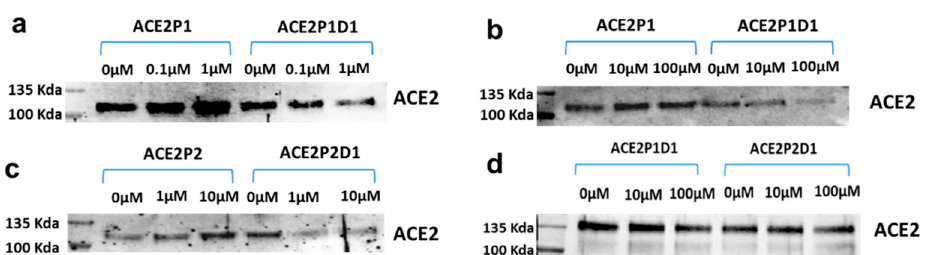
Figure 2. ACE2P1 and ACE2P2 dimers blocked the binding of spike protein to ACE2. ( a – c ) Recombinant ACE2 (0.1 µg/sample) and recombinant GST-tagged SARS-CoV2 spike proteins (0.1 µg/sample) were mixed together. ACE2P1 and ACE2P2 monomers or dimers (D1) were premixed with ACE2 for 1 h before the mixture was applied to the GST pull-down assay to determine if these compounds can block the interaction between ACE2 and spike protein. ACE2 in the pull-down assay was detected by western blot. ( d ) The interaction of recombinant ACE2 and D614G spike proteins (0.1 µg/sample) was determined by pull-down assay in the presence or absence of various concentrations of the peptoids.